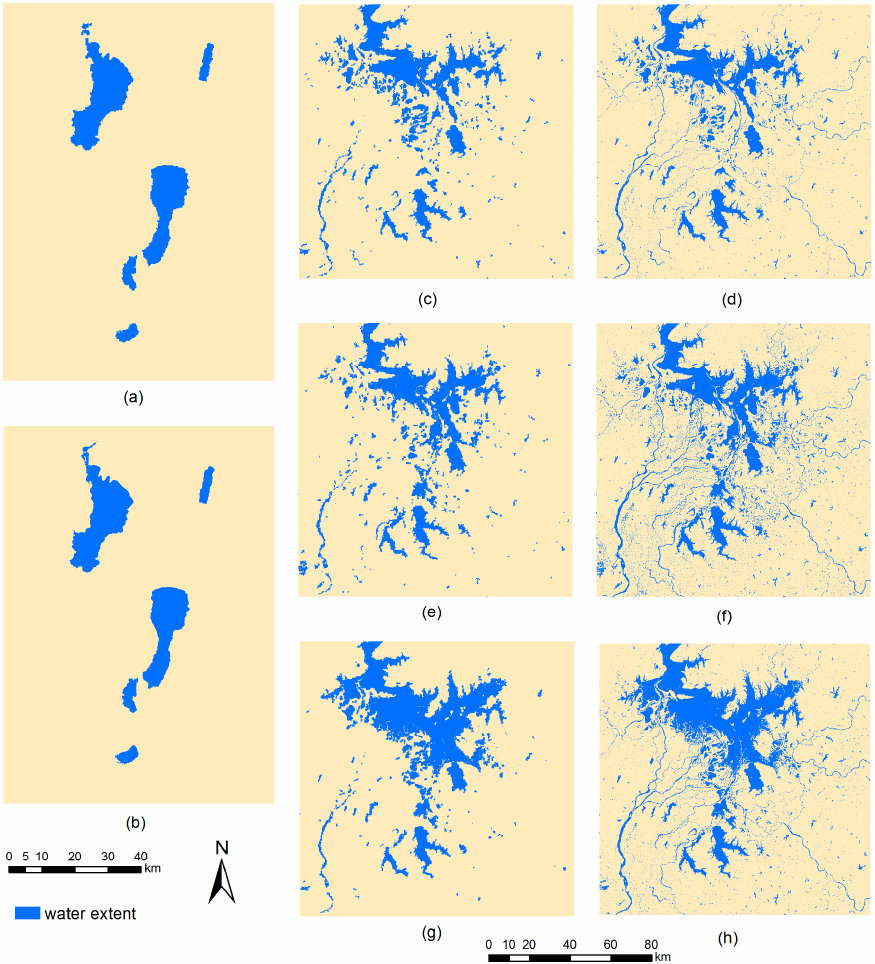
Figure 6. ( a ) Subpixel mapping result of NPP–VIIRS-derived water fraction for Yunnan lakes on 2 February 2014; ( b ) subpixel mapping result of Landsat-simulated water fraction for Yunnan lakes on